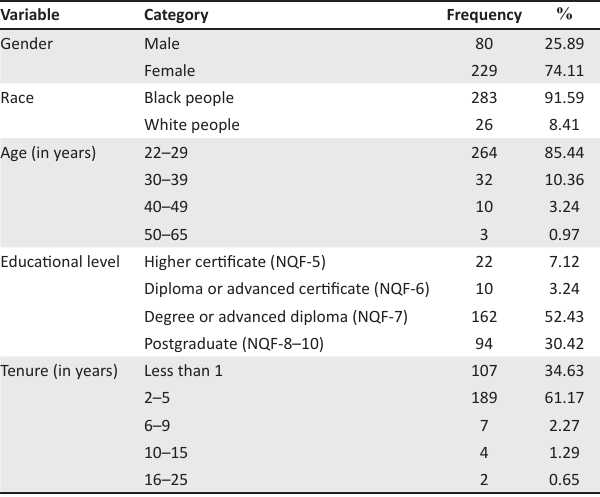
TABLE 1: Characteristics of participants.